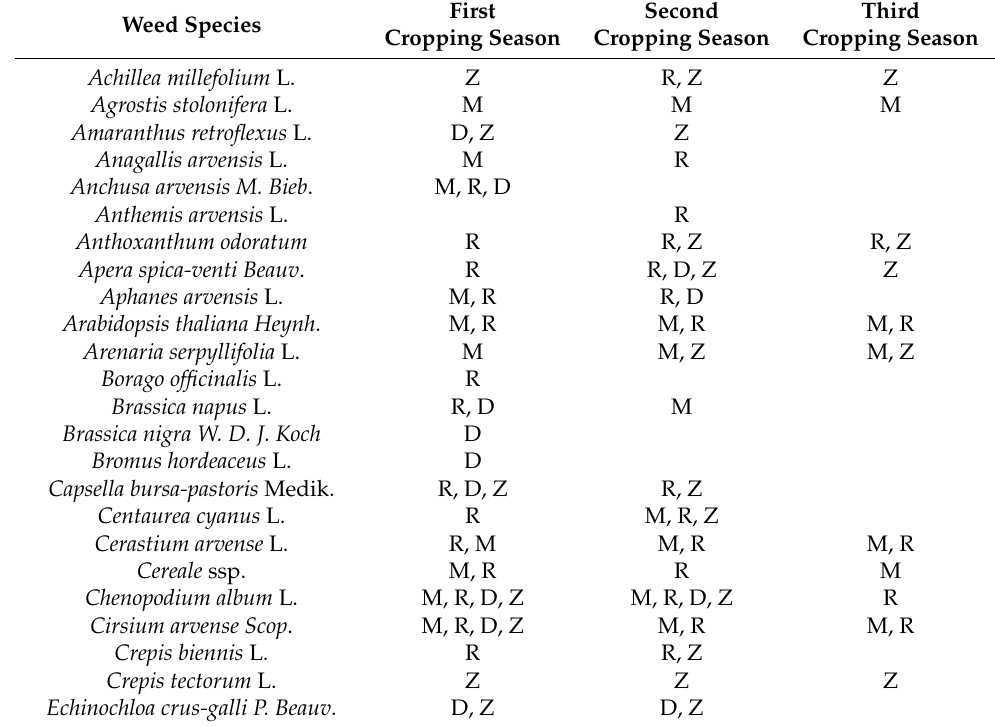
Table A1. Weed species recorded at each site during the cropping seasons. Weed species that grew on the site that cropping season are labelled with Rostock (R), Malchow (M), Dedelow (D) and Müncheberg